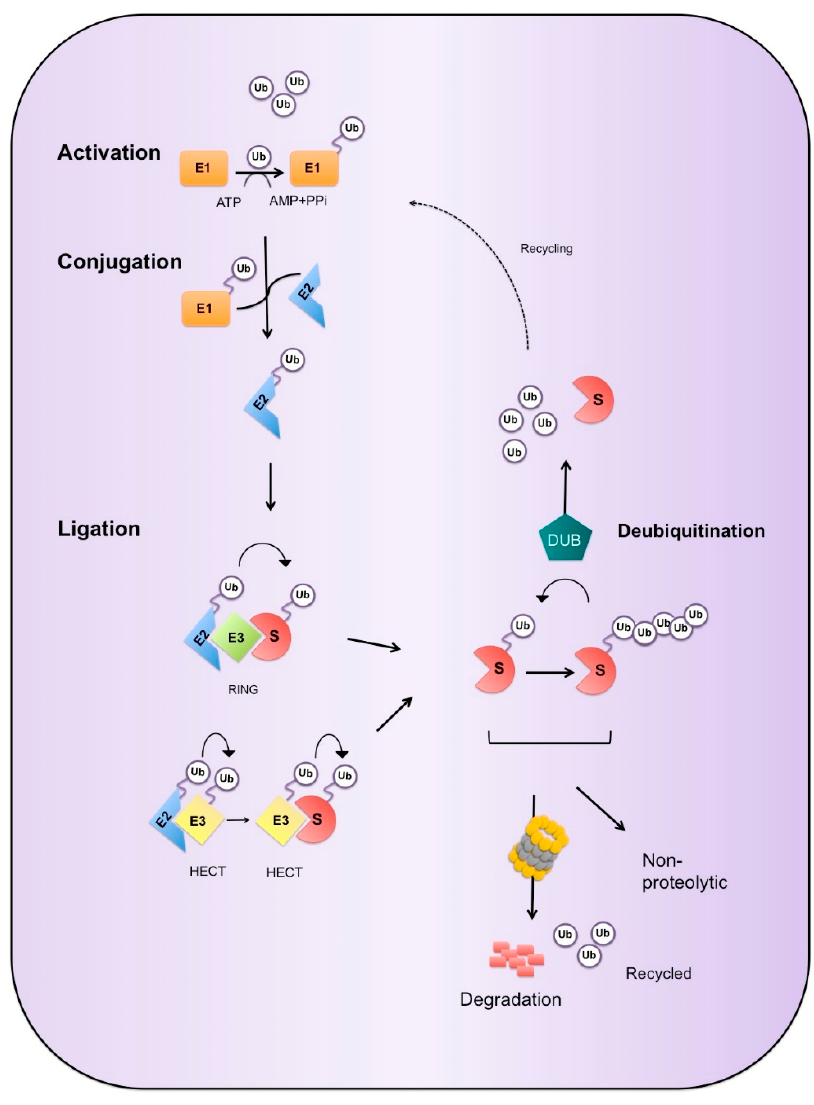
Figure 1. Ubiquitination Cascade. Ubiquitination of a substrate protein (S) occurs via a